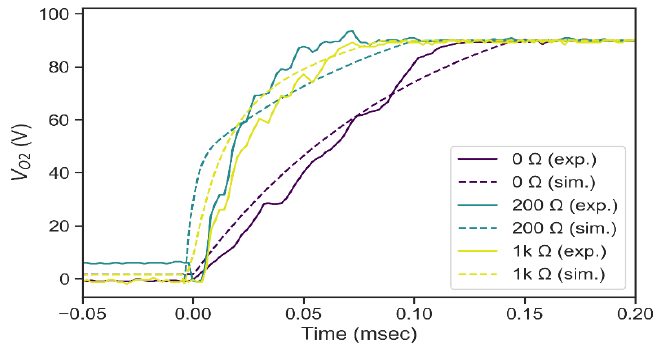
Figure 13. Comparison of experimental and SPICE simulated voltage waveform with load of a flapping wing piezoelectric actuator.